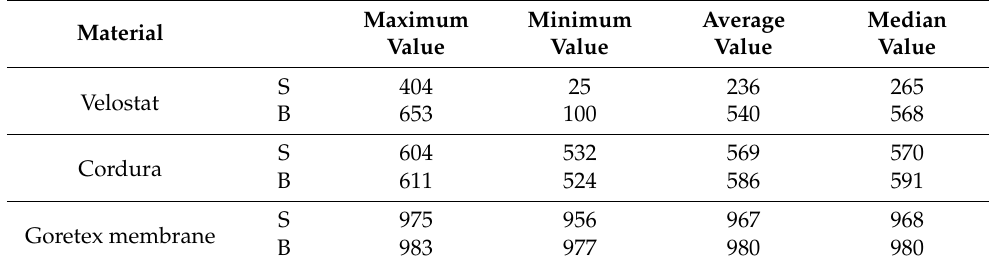
Table 2. Encoded analog signal at levels from 0 to 1023. S—straight finger; B—bent finger.